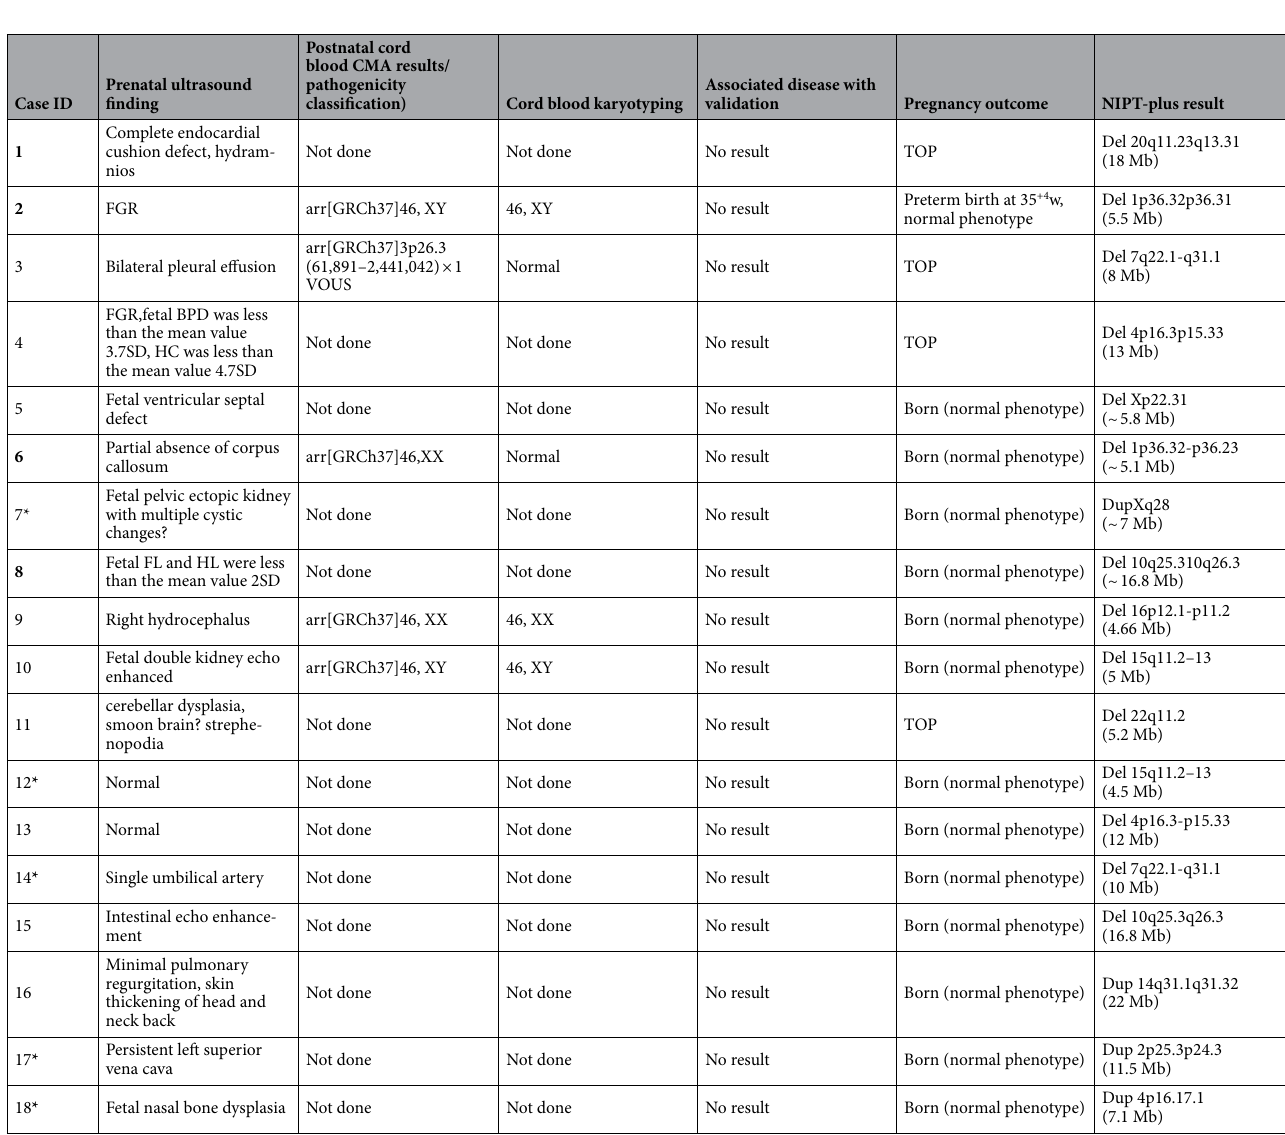
Table 6. The follow-up of 18 pregnant women with high ‐ risk CNVs detected by NIPT-Plus refused invasive testing prenatally due to fetal ultrasound structural anomalies or contraindications to prenatal diagnosis. VOUS variants of uncertain significance. *Contraindications to prenatal